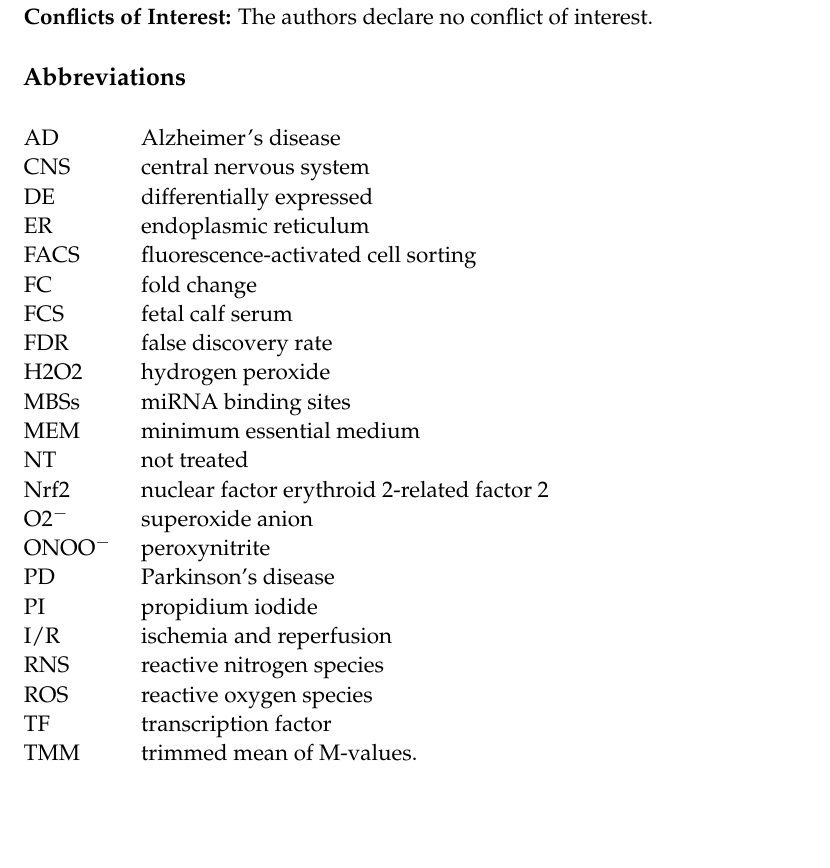
(Source of Figure 4), and their predicted and validated miRNA binding sites. Table S5: Conserved MBSs on ncRNA GAS5 and MTND4P12. Figure S1: Flow cytometry analysis of cells under oxidative stress in response to treatment with